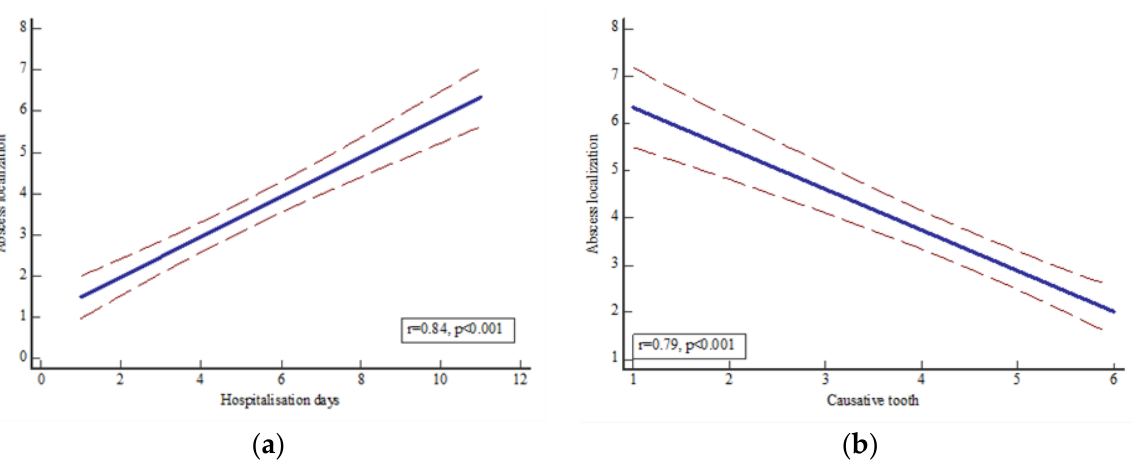
Figure 6. Significant association between ( a ) OA localization and hospitalization days ( p < 0.0001, r = 0.84, R 2 = 0.71) and ( b ) abscess localization and causative tooth ( p < 0.0001, r = 0.79, R 2 = 0.63).